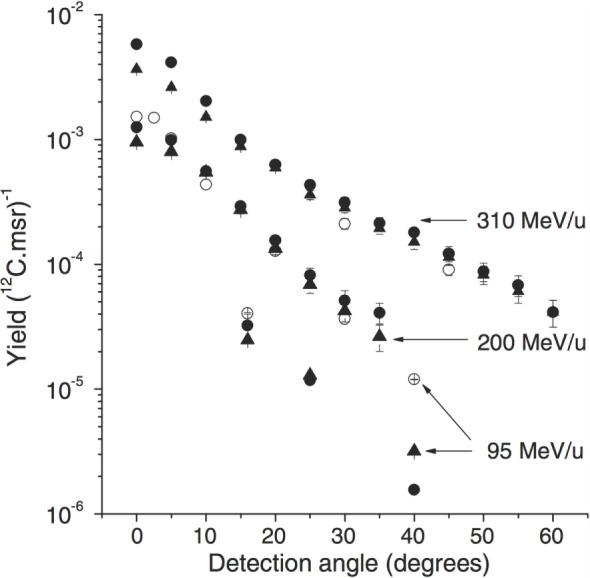
From Ref. (27): experimental (open symbols) and simulated (filled symbols) proton emission yields as a function of emission angle and carbon ion energy (and target thickness): 310 MeV/u 12C, 210 mm water target (GSI experiment), 200 MeV/u 12C, 128 mm water target (22), and 95 MeV/u 12C, 25 mm PMMA target (21). Simulations performed with the QMD (circles) and BC (triangles) models are shown. © Institute of Physics and Engineering in Medicine. Reproduced by permission of IOP Publishing. All rights reserved.